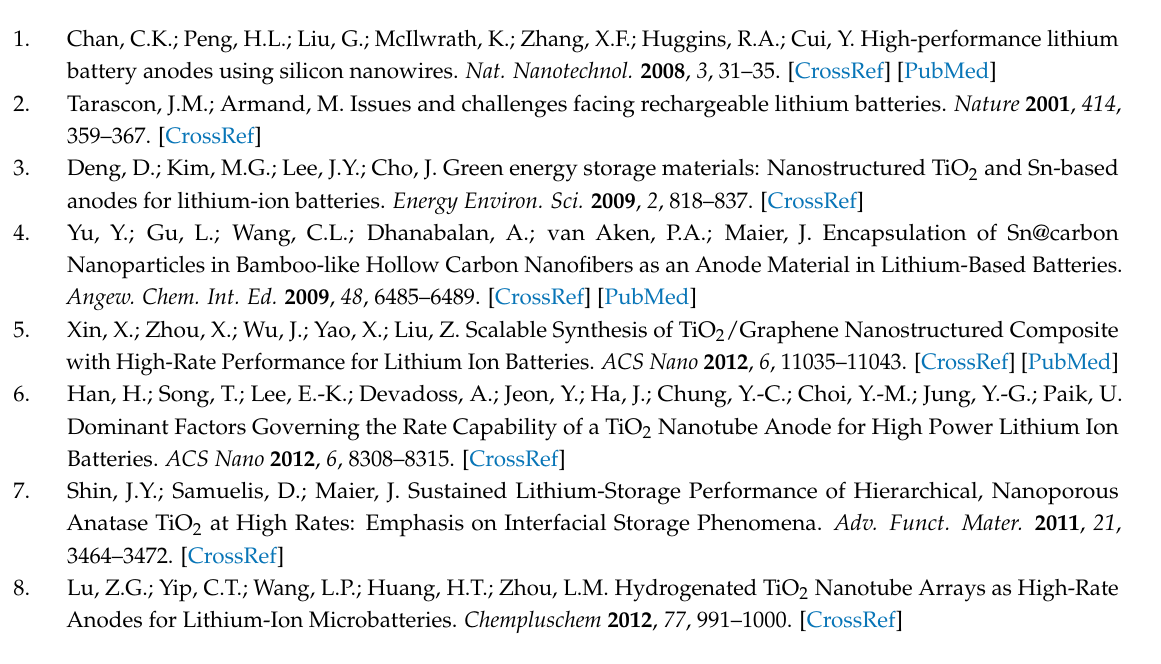
Figure S1: SEM images of (a) the TBT/PVP nanofibers (without TEOS) and the counterpart after annealing, (c) SEM and (d and inset) TEM images of the annealed TEOS-PVP fibers under the same condition, Figure S2: EDS spectra of the TEOS/TBT/PVP precursor nanofibers, TSC and TS (obtained after TGA analysis) nanofibers, Figure S3: N 2 adsorption-desorption isotherms of the TSC nanofibers, with inset showing the corresponding pore size distribution, Figure S4: Nyquist plots of the fresh TSC